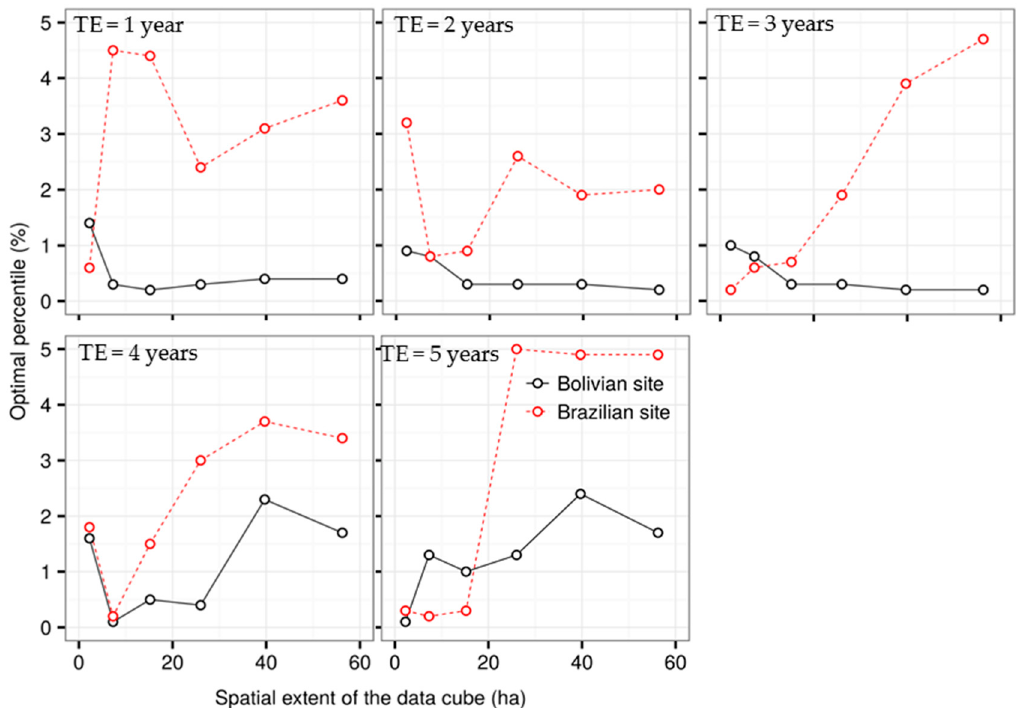
Figure 7. Change in the optimal percentile for detecting deforestation events at sub-annual scales when varying the spatial extent and temporal extent (TE) of the data cube at the Bolivian and Brazilian site. The optimal percentile was determined by choosing the percentile that achieves the shortest median temporal detection delay and highest overall accuracy based on the training data set.